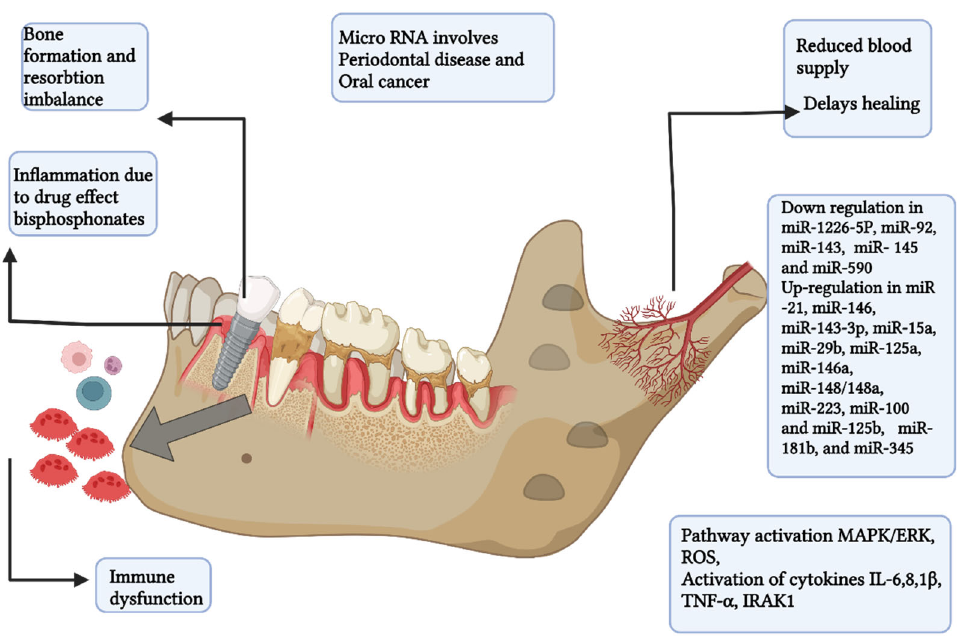
Figure 3. Schematic diagram showing events in the oral cavity. This figure was created with Biorender.com (accessed on 9 September 2022).